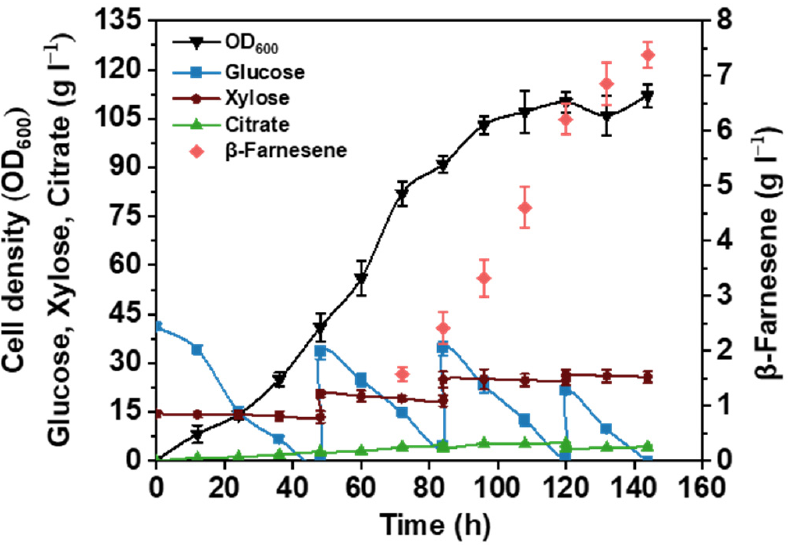
Figure 8. β -Farnesene titer, glucose and xylose consumption, citric acid accumulation, and cell density of strain FY14 in fed-batch fermentation. Data are represented as mean ± standard deviation (n = 3).